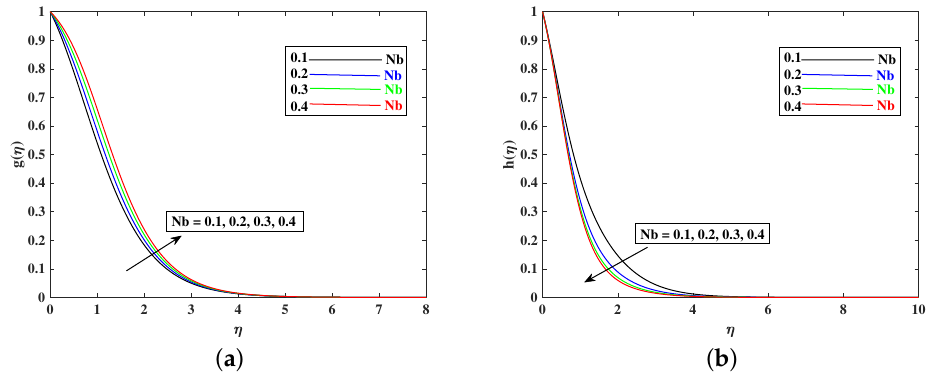
Figure 10. Variation of Nb to influence the temperature and concentration profile. ( a ) Variation of Nb to influence the temperature. ( b ) Variation of Nb to influence the concentration profile.